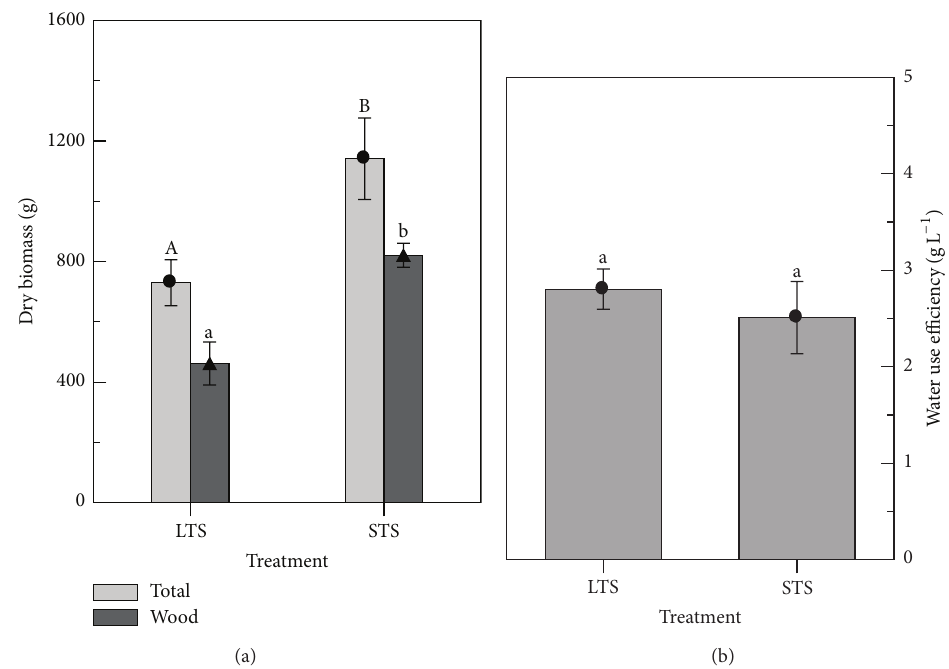
Figure 10: (a) Mean and standard deviation of the above ground dry total biomass and dry wood biomass produced during the vegetation period; (b) mean and standard deviation of the water use efficiency under different drought stress duration. ∗ Nonparametric analysis Mann- Whitney 𝑈 test. ∗ Different letters indicate significant difference ( 𝑃 < 0.05